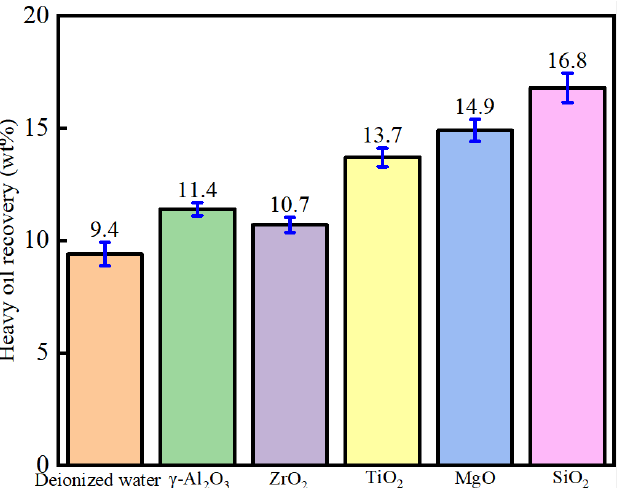
Figure 5. Heavy oil recovery using heavy-oil–carbonate-solid separation enhanced by five nanofluids (0.1 wt%).